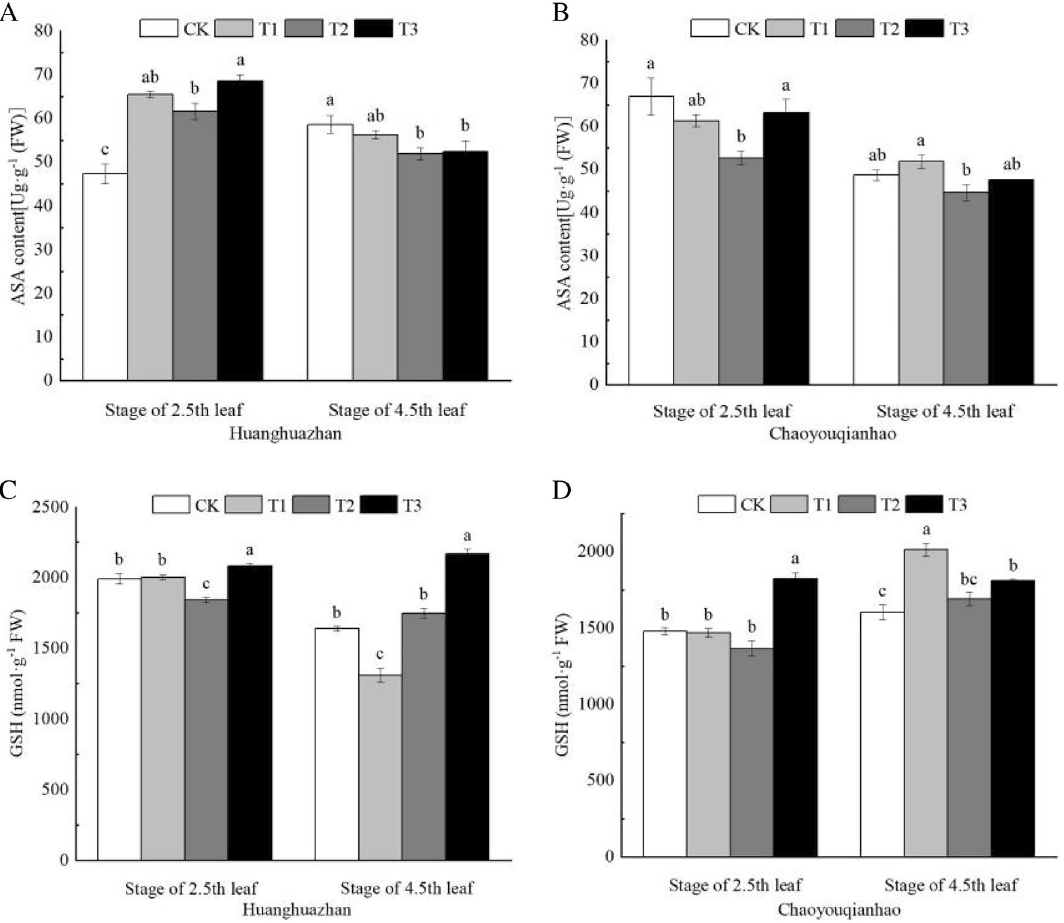
Figure 6. Effects of soaking with BR on antioxidant in rice seedlings under salt stress. Different lowercase letters indicate significant differences at the P ≤ 0.05 level. CK: soaking with distilled water + watering 0 g L −1 NaCl. T1: soaking with BR + watering 0 g L −1 NaCl. T2: soaking with distilled water + watering 3 g L −1 NaCl. T3: soaking with BR + watering 3 g L −1